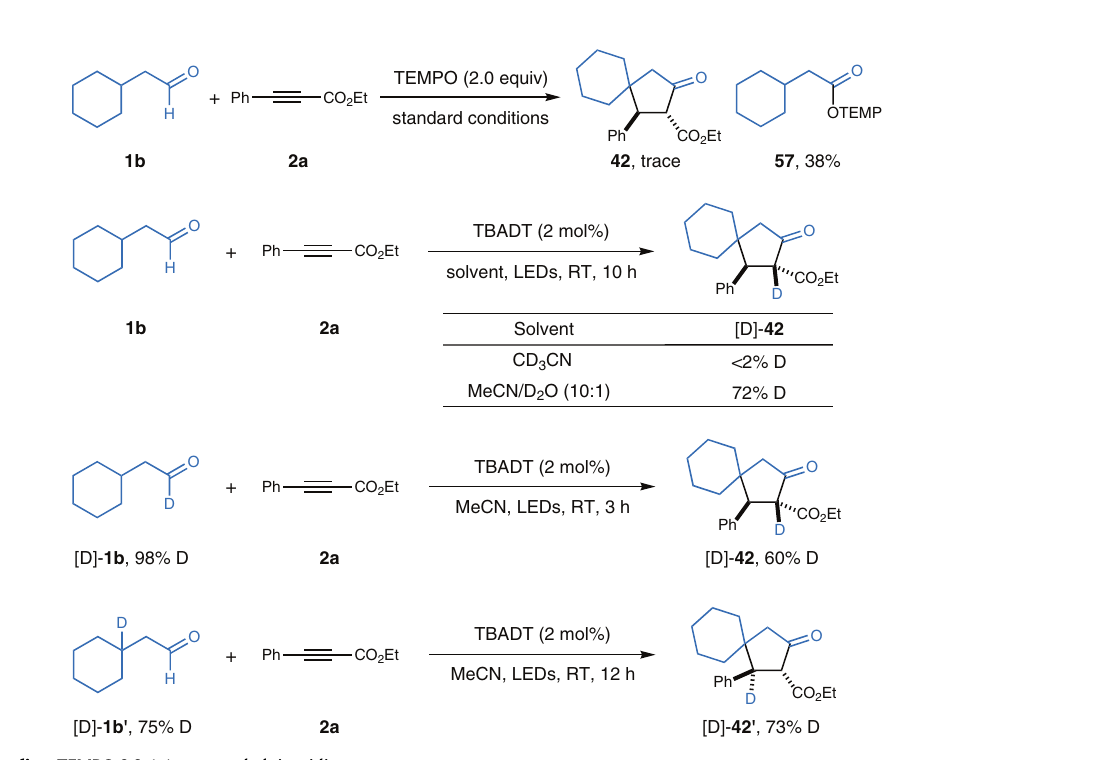
Fig. 4 | Mechanistic studies. TEMPO